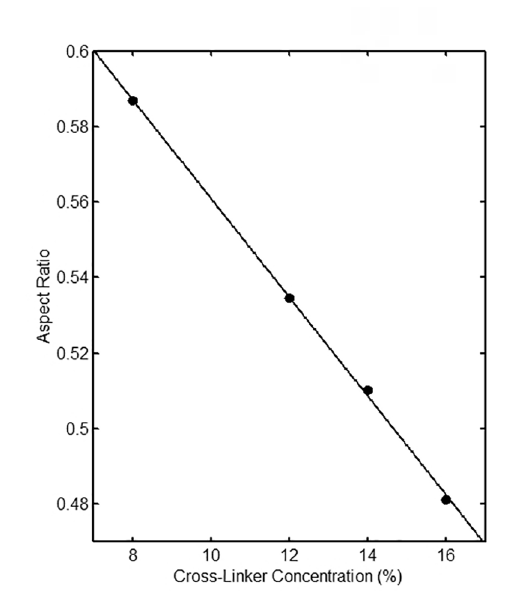
Figure 4. A linear regression of the maximum aspect ratio AR(110 ºC)/AR(30 ºC) with respect to the cross-linker concentrations, where the higher the cross-linker concentration, the lower the aspect